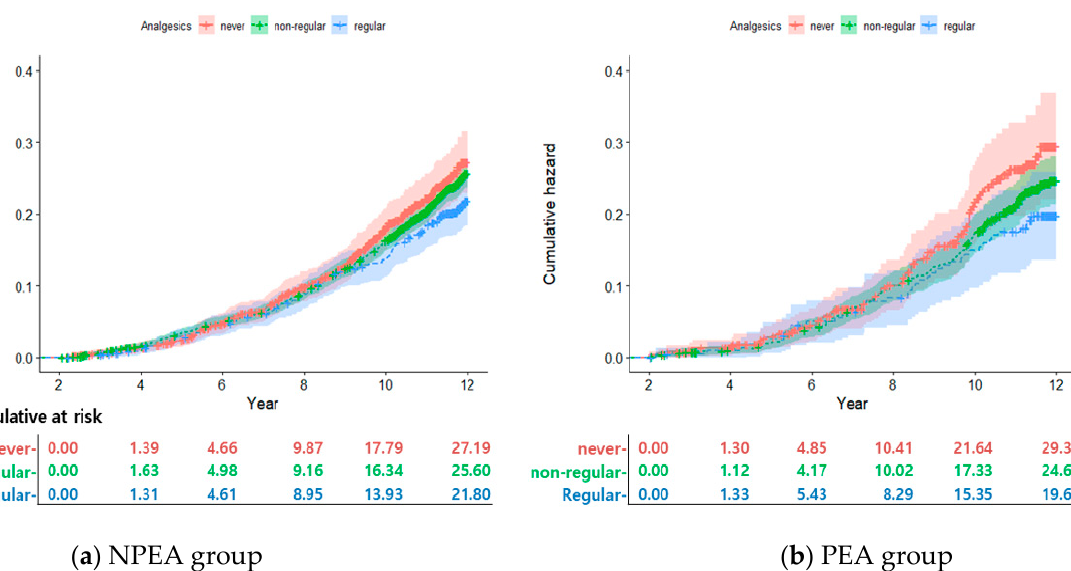
Figure 1. Cumulative incidence of breast cancer according to analgesics